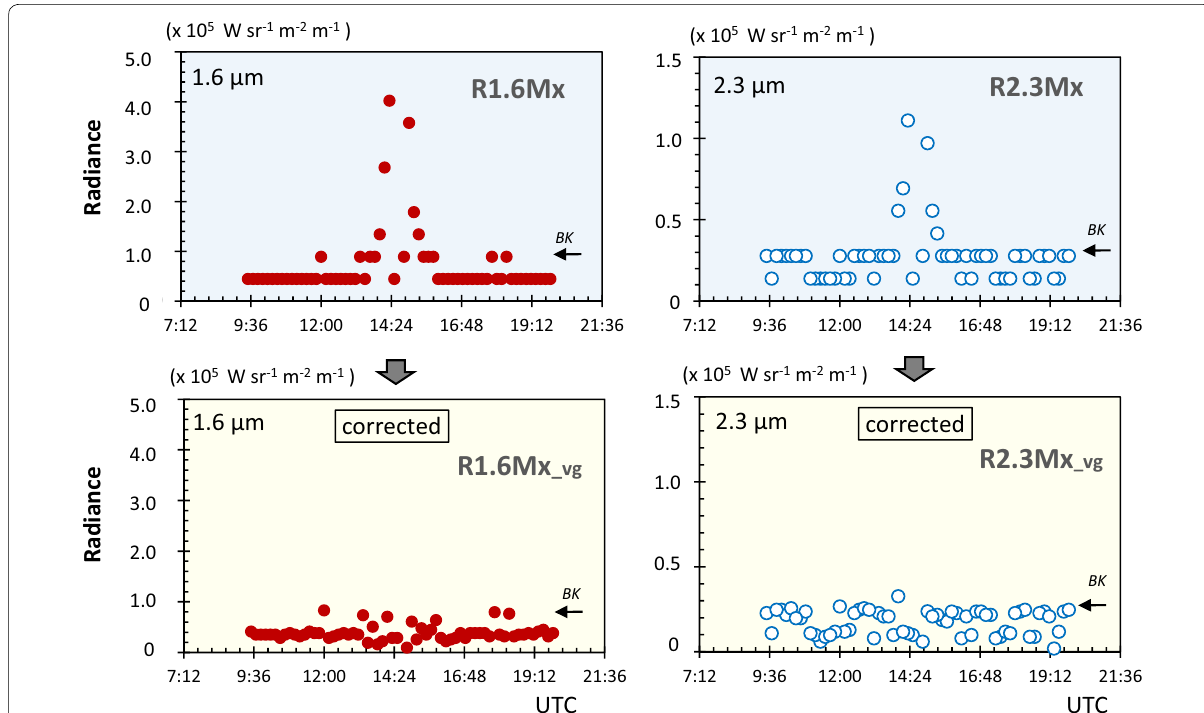
Fig. 4 Comparison between uncorrected and corrected data for stray light using the time-series variation of nighttime thermal anomalies in the 1.6-µm and 2.3-µm images between 8:24 and 20:24 UTC on April 9 (close to the apex of the spring anomaly peak but before the Phase 2